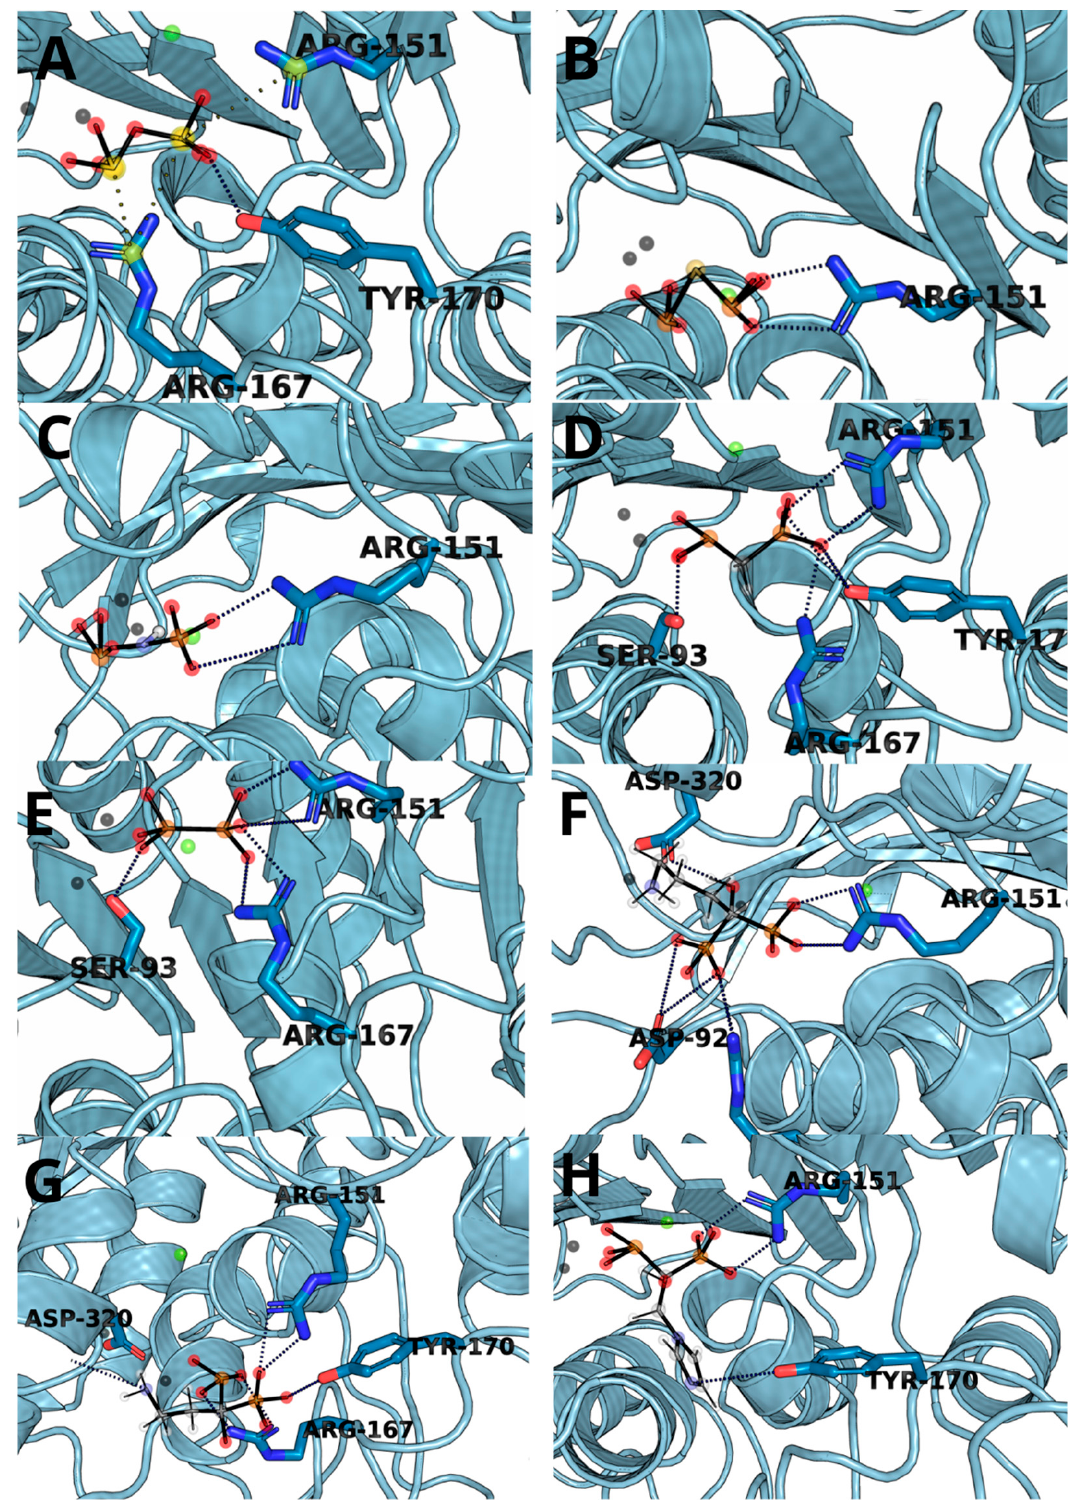
Figure 5. Representative spatial orientation of ( A ) pyrophosphate, ( B ) monothiopyrophosphate, ( C ) imidodiphosphate, ( D ) methylenediphosphonic acid, ( E ) hypophosphate, ( F ) alendronate, ( G ) pamidronate and ( H ) zoledronate from the molecular dynamics simulation. MD investigation indicates significant influence of metal ions (zinc—black sphere, magnesium—green sphere) on ligand binding, as they are close (apart from alendronate) to deprotonated moieties and yield low contribution energies.